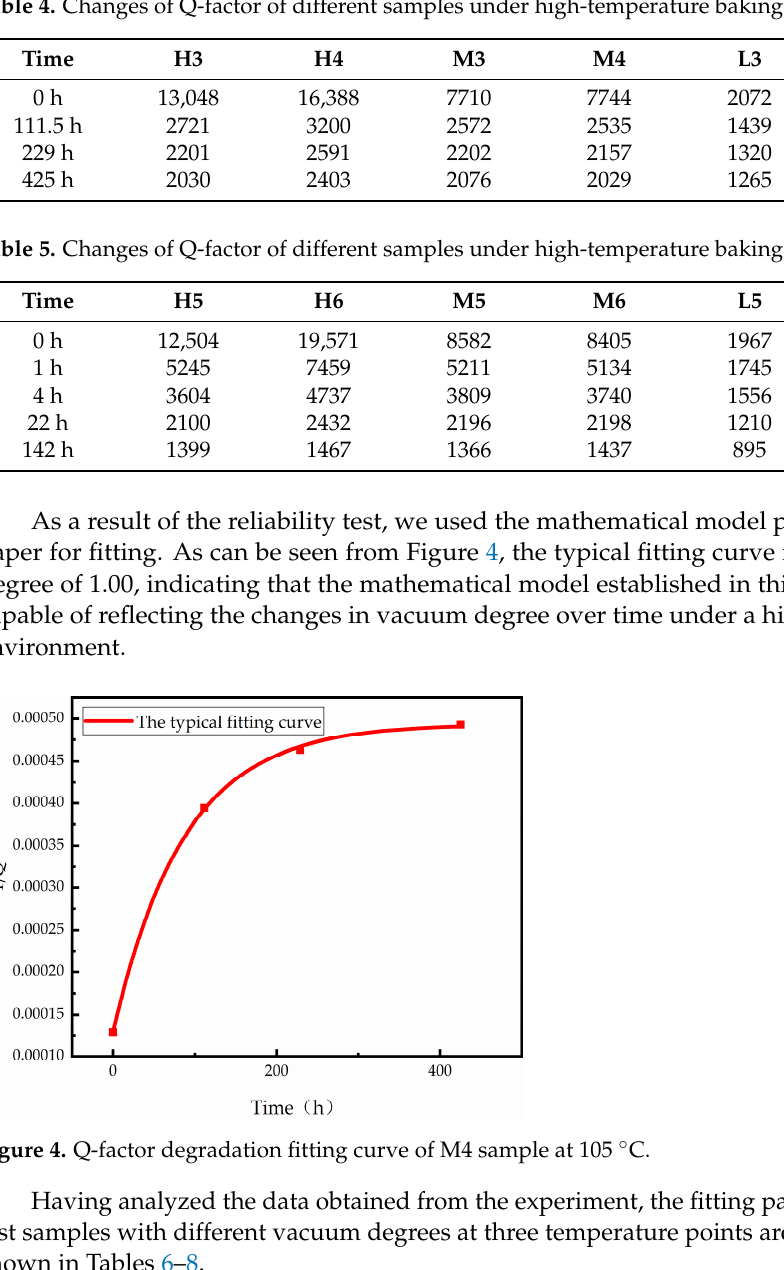
Table 6. Parameter values of Q-factor degradation fitting curve baking at 85 °C.